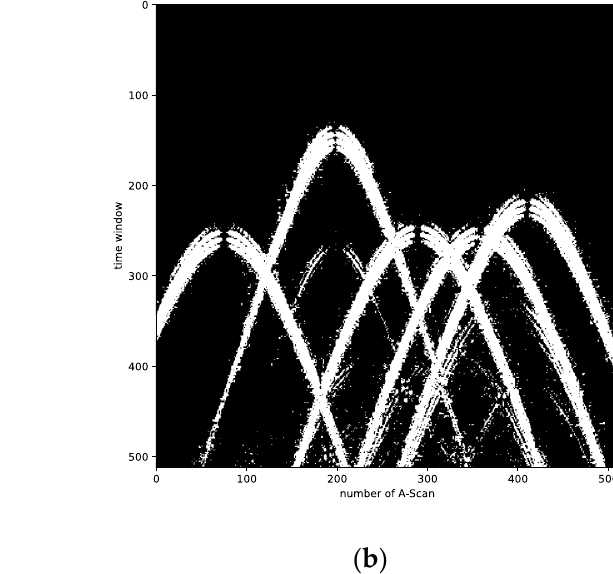
Figure 5. Longitudinal and transverse gradient graphs after binarization. ( a ) Longitudinal gradient graph combined with the upward and downward gradient graph. ( b ) Transverse gradient graph combined with the left and right gradient graph.